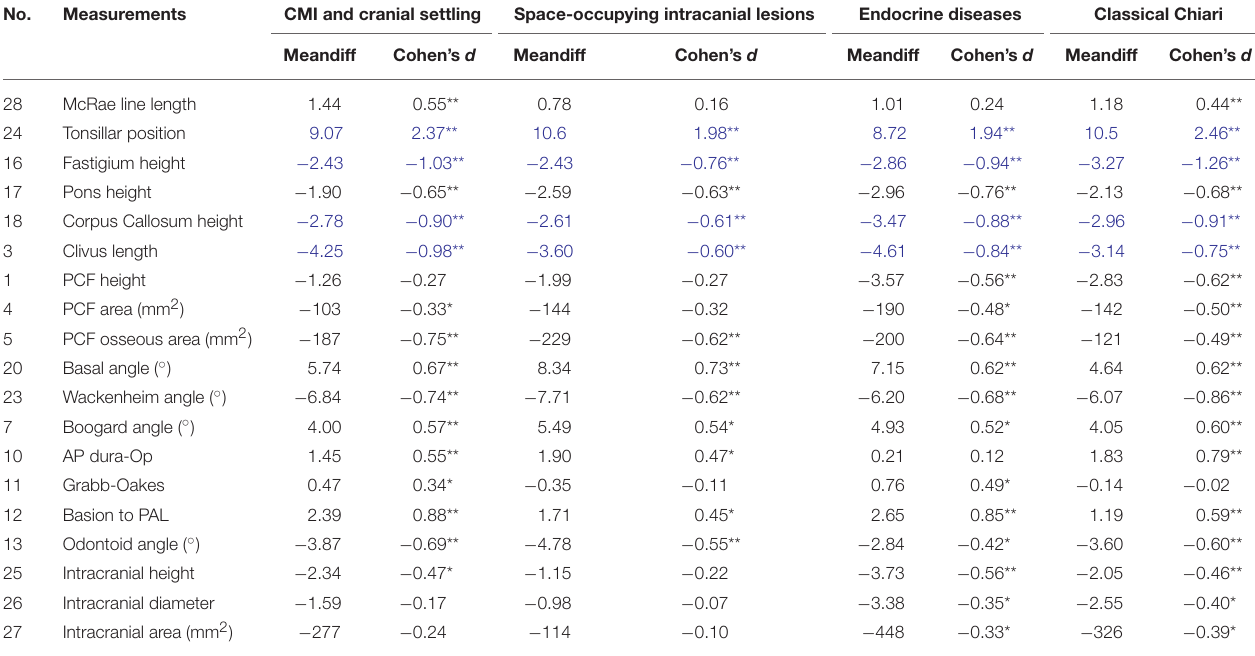
TABLE 6 | Descriptive statistics for comparison of CMI participants when evaluated by Etiological Factor Groups and control participants.